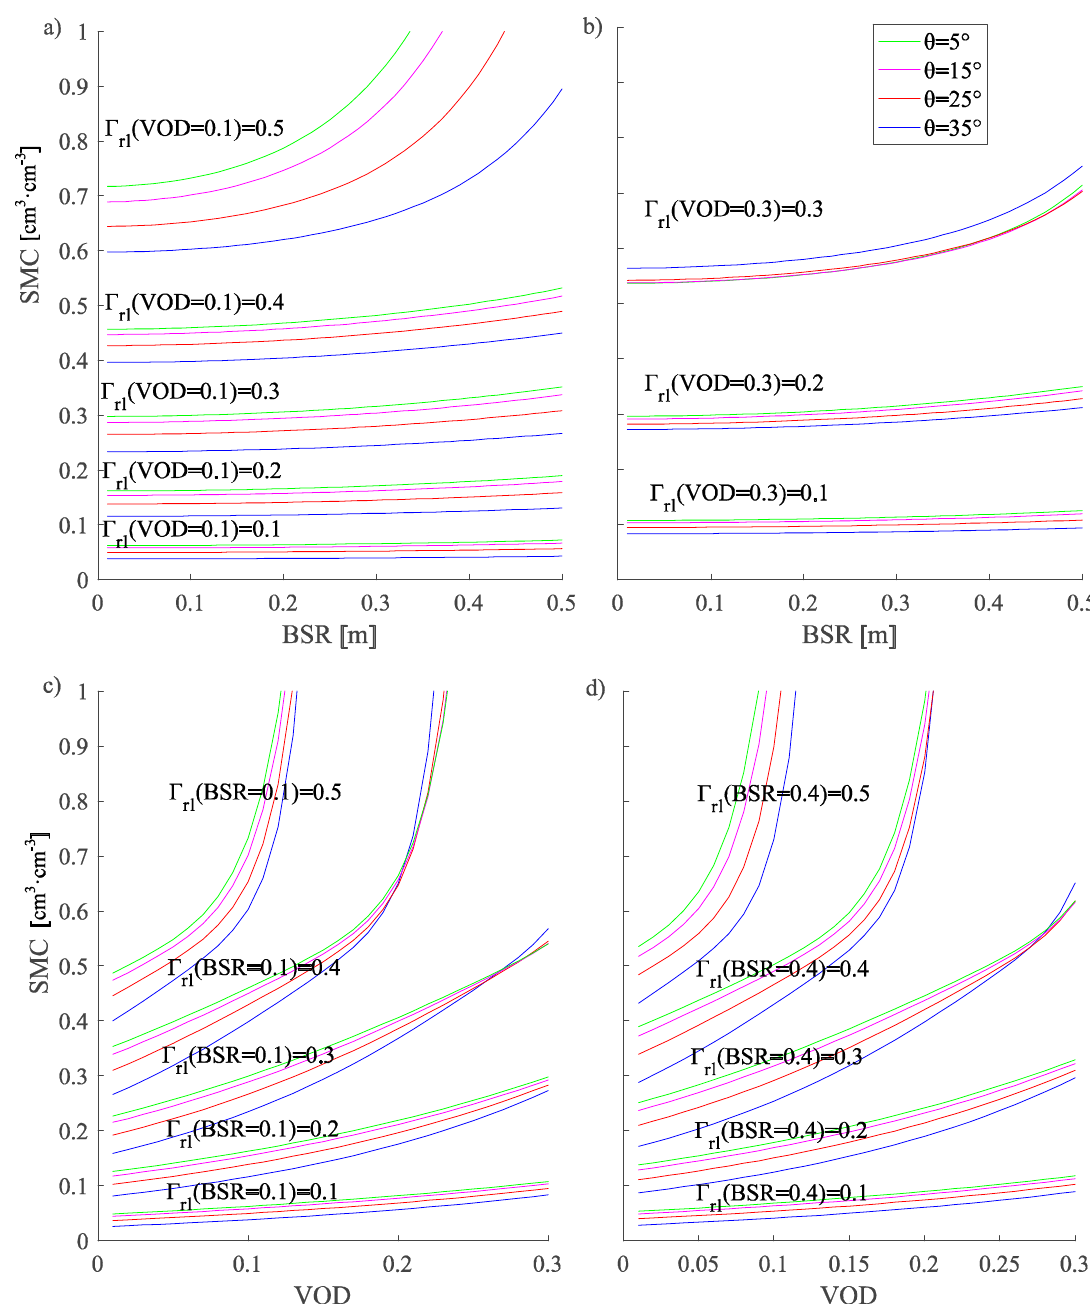
Figure 7. SMC reflectivity model sensitivity analysis to variable incidence angle θ , BSR, and VOD for uncorrected reflectivity measurements ( Γ lr ) from 0.1 to 0.5 at 0.1 intervals. In the top panels with respect to BSR for ( a ) VOD = 0.1 and ( b ) VOD = 0.3, in the bottom panels with respect VOD for ( c ) BSR = 0.1 and ( d ) BSR = 0.4.